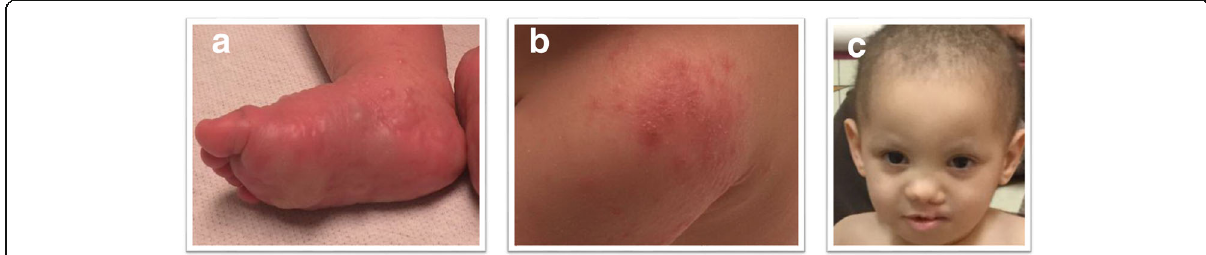
Fig. 1 Clinical photographs of the index patient. a - b Mild 2 nd , 3 rd toe syndactyly, eczema, recurrent onychomadesis, recurrent skin infections causing desquamation; c the patient at 2 years of age - sparse hair, eyelashes and eyebrows, depressed flat nasal bridge, hypoplastic alae nasi, thin vermillion border, mild epicanthus, ankyloblepharon and unilateral left cleft lip and palate s/p repair